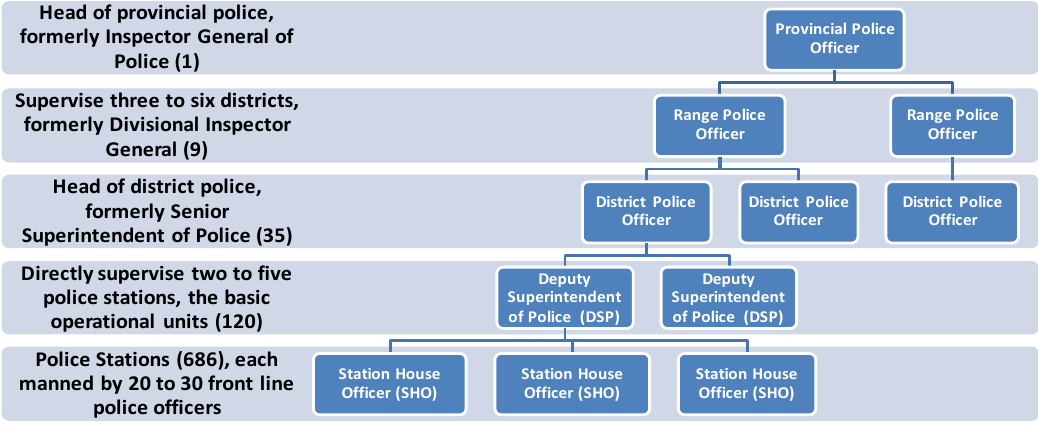
Figure 5. Pakistani Police Organizational Chart